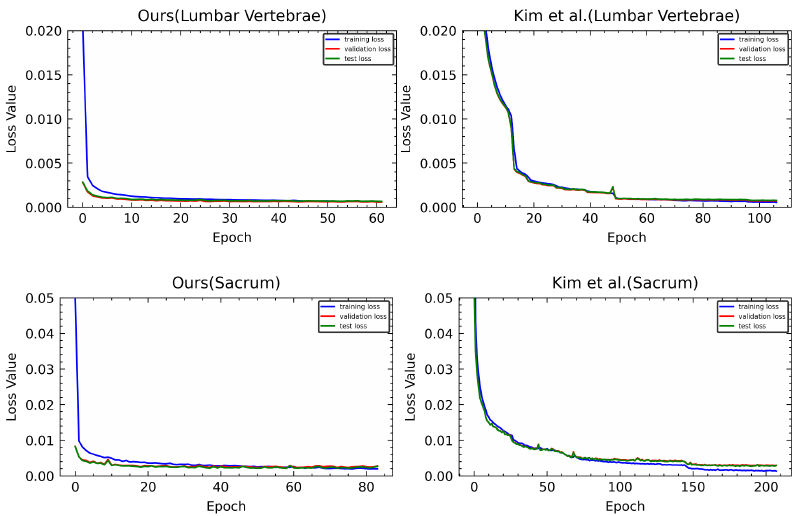
Figure 21. Loss graphs of ours and Kim et al. [5]. The first row is a loss graph of M-Net predicting the landmark of the lumbar vertebrae, and the second row is a loss graph of M-Net predicting the landmark of the